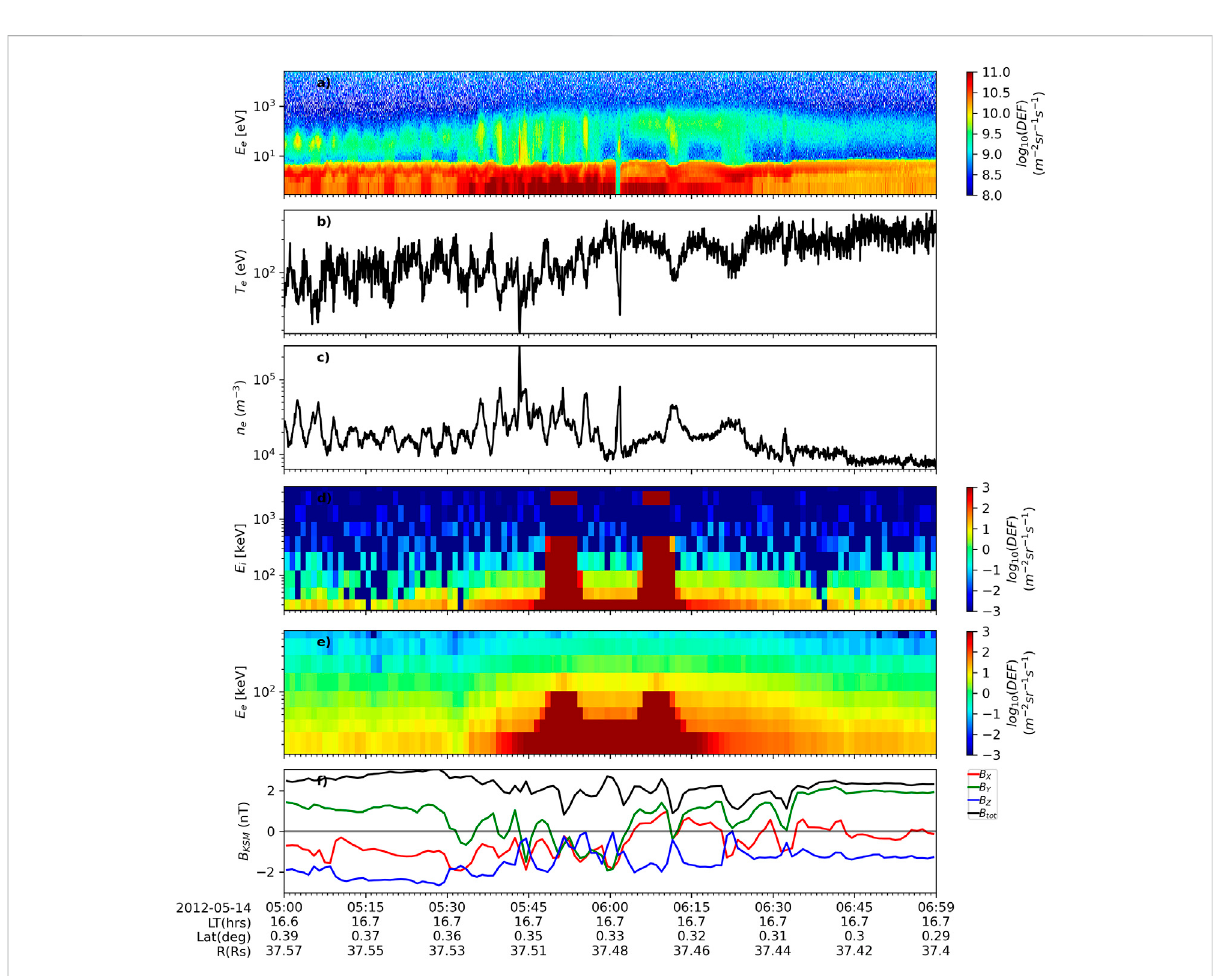
FIGURE 11 A 2-h interval encompassing a potential K-H vortex encounter. The panels are as follows: (A) Electron energy-time spectrogram of differential energy fl ux(DEF)fromCAPS/ELSanode5. (B,C) ElectrontemperatureandnumberdensityderivedfromELSanode5. (D,E) Energy-timespectrogram ofionand electron intensity fromLEMMS. (F) ThemagnitudeandKSM components ofthemagnetic fi eld.Spacecrafttrajectory information isshown below the x